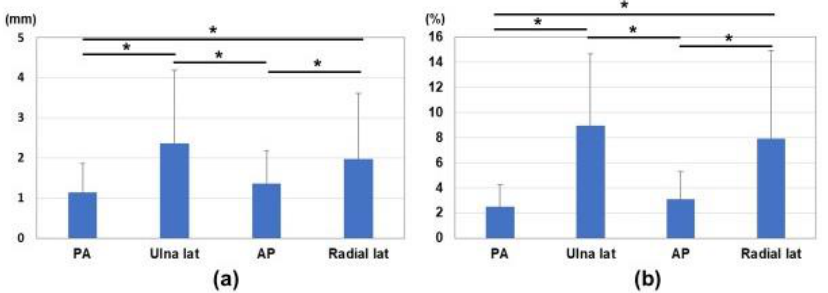
Figure 6. The average differences of the marker distances between measurements on the fluoroscopic image and estimated 3D image. ( a ) Average differences in measured values on the fluoroscopic image and 3D bone image for each marker. ( b ) Ratios of differences in the actual values (measurement difference/actual measurement in the fluoroscopic image). *: p < 0.05.